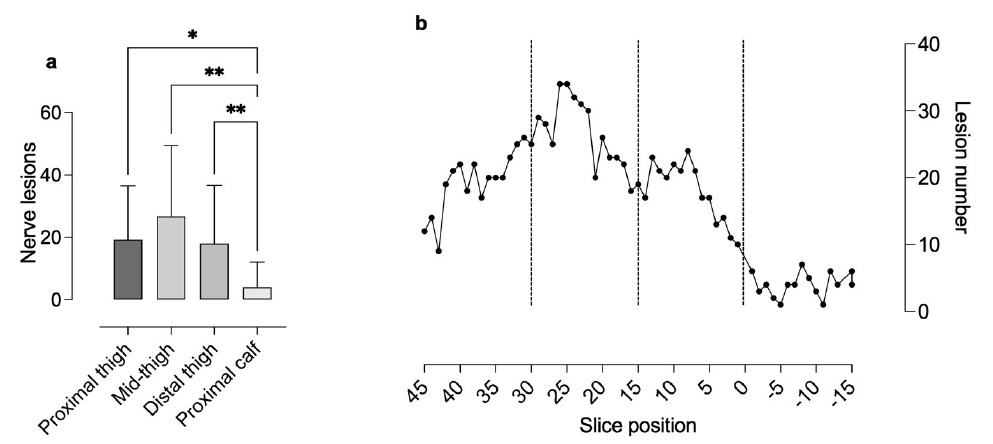
Figure 2. Analyses of peripheral nerve lesion numbers per level (proximal thigh, mid-thigh and distal thigh level and proximal calf) ( a ) and their spatial distribution from proximal to distal ( b ) Analyses of lesion number per level revealed a higher number of microlesions at the thigh levels compared to the calf level. Distribution analysis showed an increase in nerve lesions from the proximal (slice 45 to 30) to the mid-thigh (slice 30 to 15) level and a subsequent decrease towards the distal thigh (slice 15 to 0) and calf (slice 0 to − 15) level (Ns non-significant, * p < 0.05, ** p < 0.01).